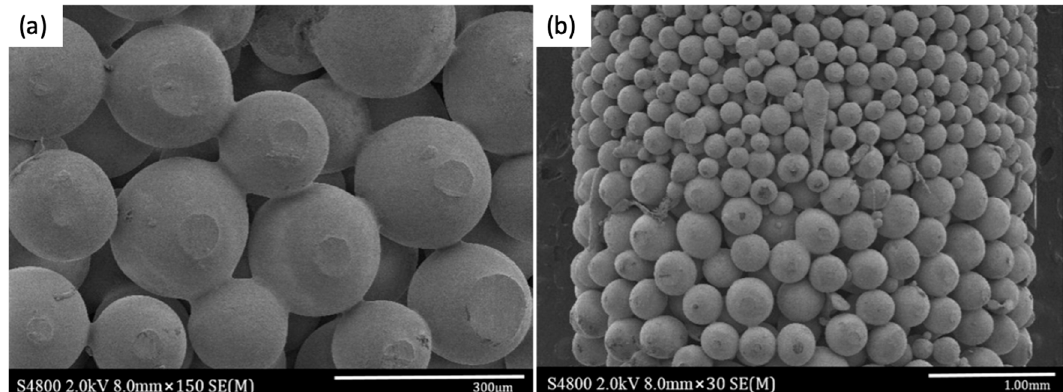
Figure 4. ( a ) Fused poly (D, L-Lactide) (PDLA) microspheres coated with TiO 2 nanoparticles at 90 °C for 45 min and ( b ) detail of the pore size gradient of the scaffold obtained by the heat sintering method [49]. Figure reprinted from Nanomedicine: Nanotechnology, Biology and Medicine, 13, Morteza